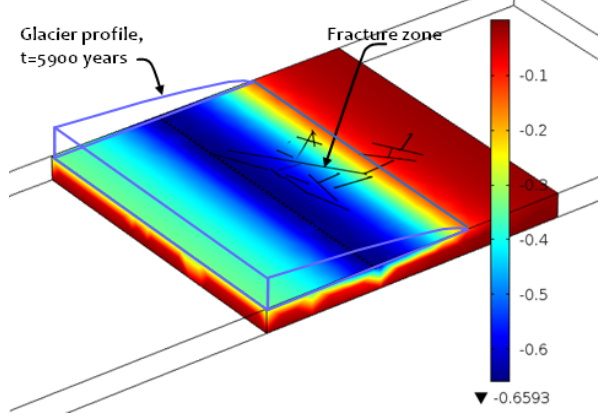
Figure 16. Temperature change distribution [ ◦ C] within the rock mass 5900 years after the start of the glacier